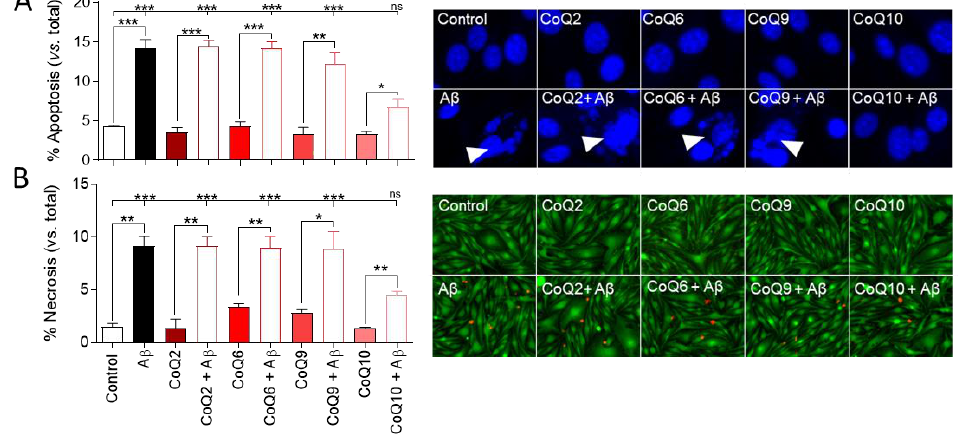
Figure 1. Analysis of apoptosis and necrosis in bEnd.3 cells exposed to A β 25–35 and different coenzyme Q homologues (CoQs). Cells were pretreated with CoQ2, CoQ6, CoQ9, or CoQ10 for 24 h and then treated with A β 25–35 for 24 h. ( A ) Apoptosis was determined by morphological criteria in cells stained with Hoescht 33258 (white arrows point to apoptotic nuclei). ( B ) Necrosis was determined by quantifying necrotic cells (EtBr positive cells — red) versus viable cells (Calcein-AM positive cells — green). Results show the percentage of apoptotic or necrotic cells versus total cells. Data are presented as the mean ± SEM. Student’s t -test was used to compare the differences between groups treated with the same ubiquinone and Dunnett’s multiple comparison test to compare each Aβ 25-35 (plus or minus ubiquinone) treatment with the control. ns: not significant, * p < 0.05, ** p < 0.01, *** p < 0.001, ( n = 3).